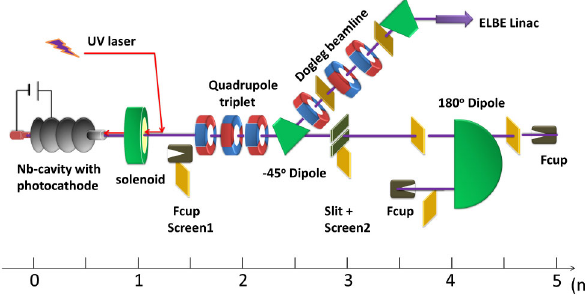
FIG. 2. The schematic view of the gun, the diagnostic beam line, and the dogleg beam line connecting the setup to the ELBE linac. The − 45 ° dipole, 2.39 m downstream from the cathode, can guide the beam through the achromatic dogleg into the ELBE Linac. Alternatively, the electron beam reaches the 180°-bending dipole for energy and energy spread measurements. Beam position monitors and steerers are not shown FIG. 1. Top: The cavity shape of the ELBE SRF gun. Bottom: The distribution of the electric surface field j E j and the axis field E E ¼ 16 . 2 MV = m. z , simulated using S UPERFISH [21] with z .max The solid red line and the blue dashed line are respectively the case with cathode plug or without cathode plug, while the black dots show the acceleration field E z along the z axis (without cathode). Inset: The distribution of the electric surface field in the zone close to the cathode ( z ¼ 2 . 6 cm to 3.2 cm) [20].